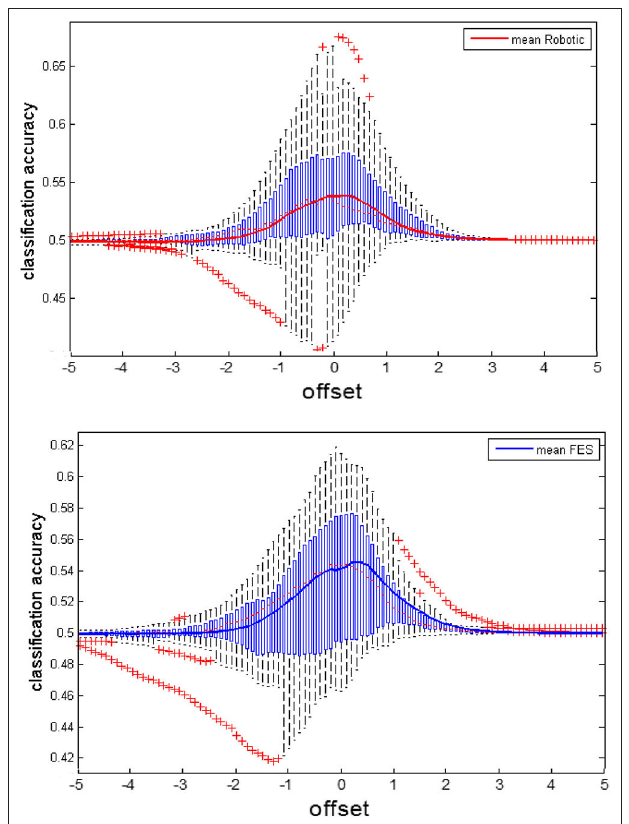
FIGURE 6 | Classification accuracy of the feedback modalities. We recalculated the classification accuracy (CA) offline for various thresholds to estimate capacities for cognitive load (see also Bauer and Gharabaghi, 2015a). The subfigures show the average CA as solid trace, on top of boxplots indicating the distribution of CA within the group. Boxplots are characterized by the red dotted line indicating the median, the blue boxes indicating interquartile ranges (IQR) and the whiskers indicating 1.5 IQR. Red crosses mark extreme values outside the whiskers. The upper subplot shows the CA for the BRI task, the lower subplot for FES.